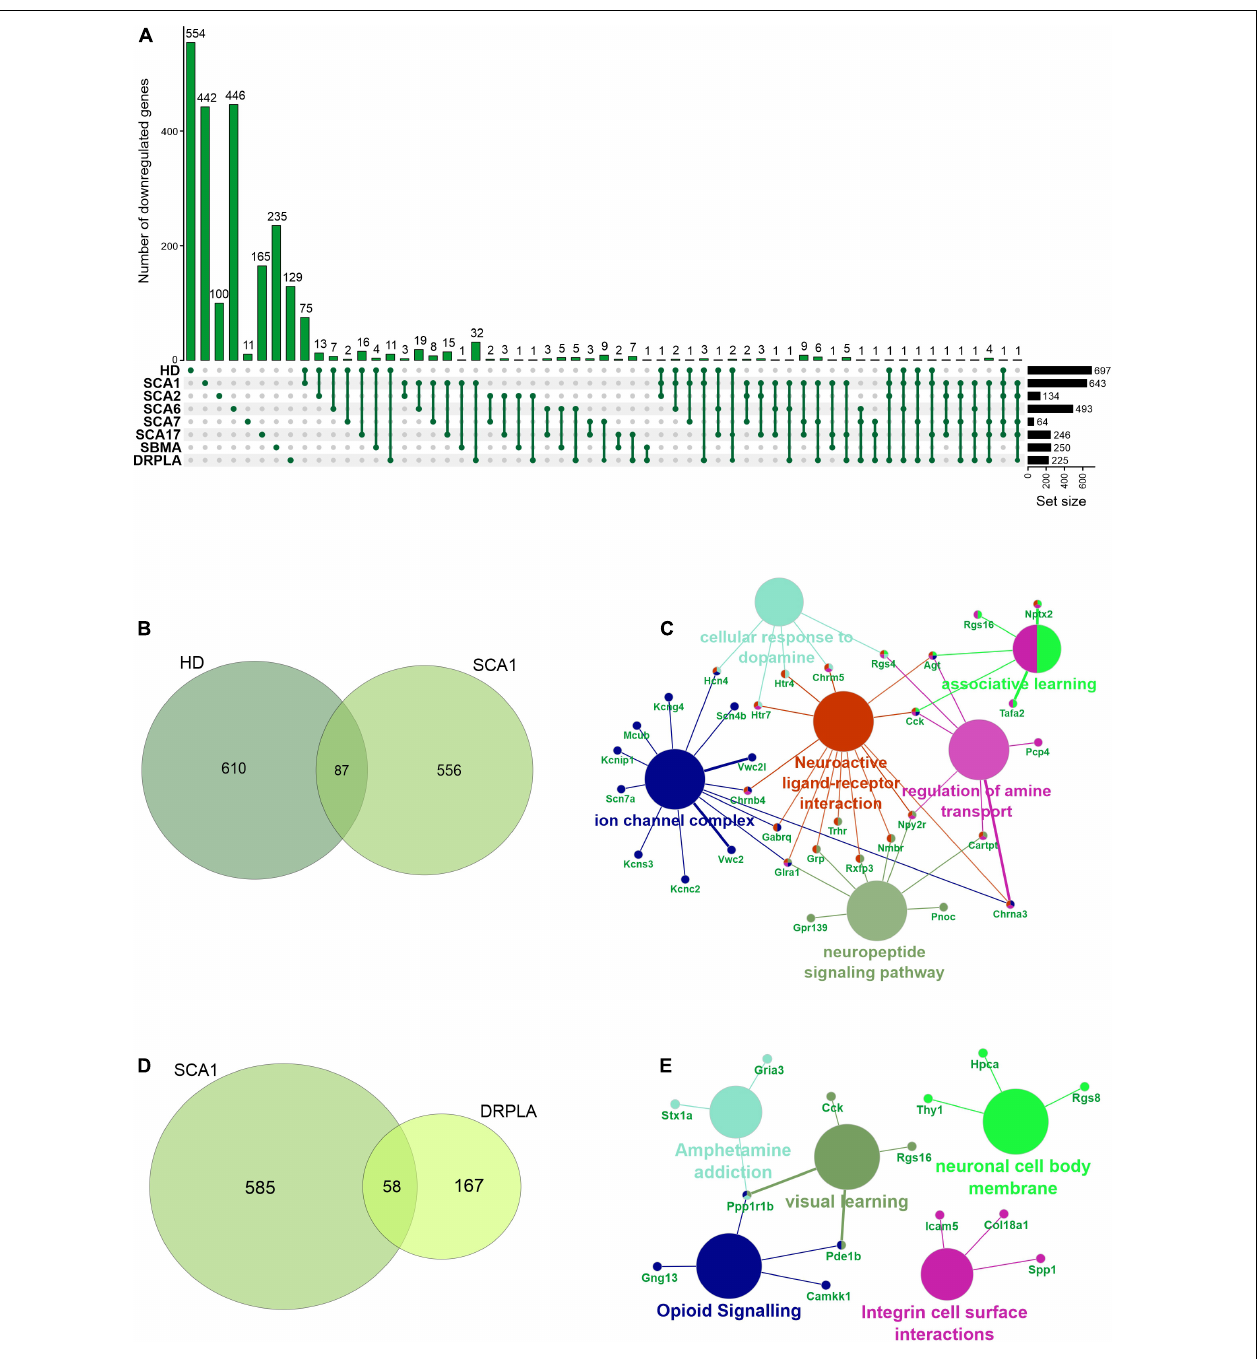
FIGURE 4 | Overlap of significantly downregulated genes from mice transcriptomic data from different PolyQ diseases. (A) UpsetR analysis was used to see the overlap between downregulated genes identified in different PolyQ diseases. Venn diagrams visualizing the overlap between downregulated genes in HD and SCA1; (B) and for overlapping genes downregulated in SCA1 and DRPLA (D) . ClueGO analysis was used to visualize the biological processes in which the commonly downregulated genes between HD and SCA1 (C) and between SCA1 and DRPLA (E) are